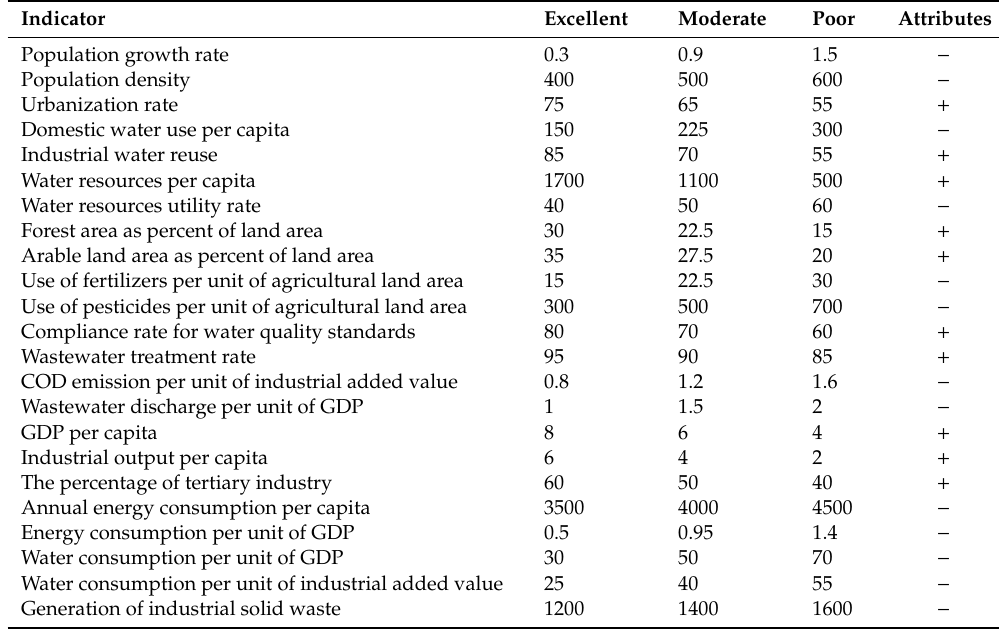
Table 3. Grading criteria of